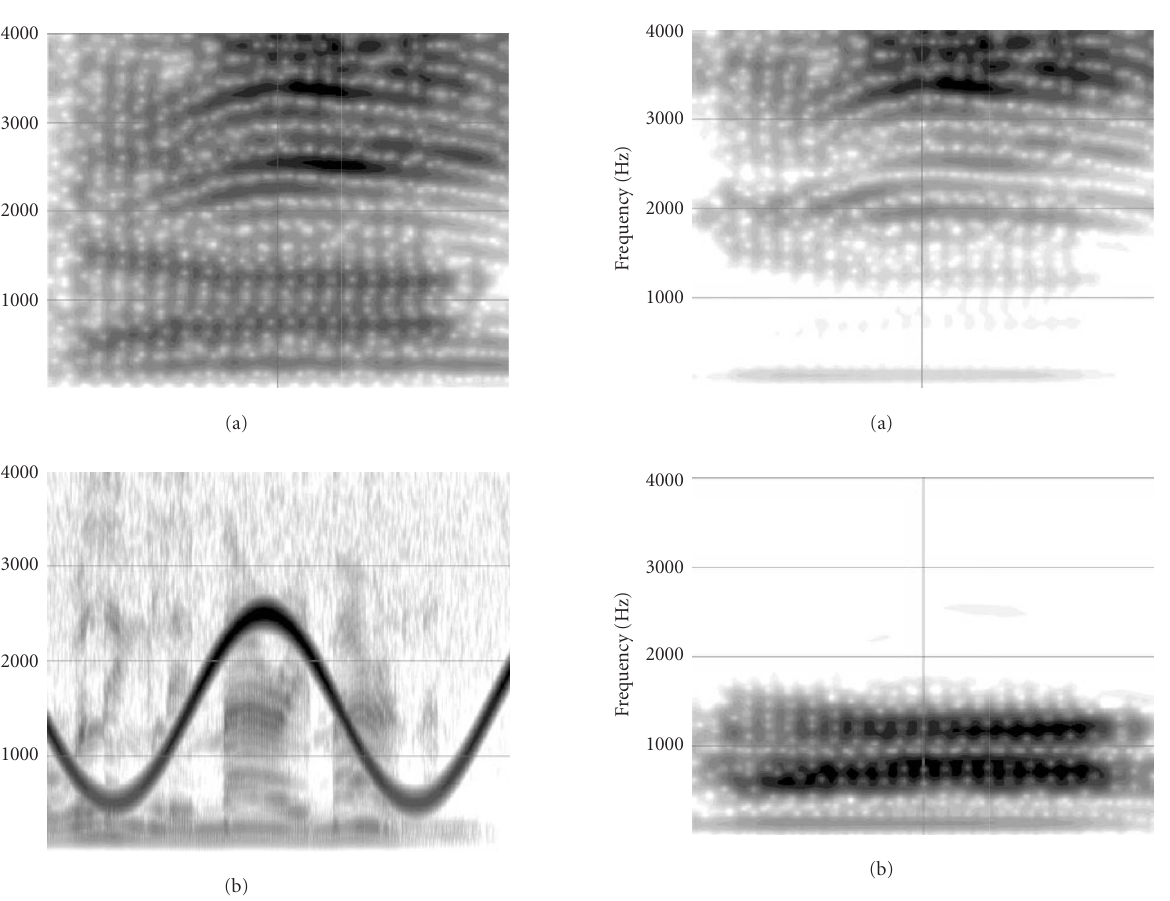
Figure 5: (a) Spectrogram of the /di/ and /da/ mixture. (b) Spectro- gram of the sentence “I willingly marry Marilyn” plus siren mixture.